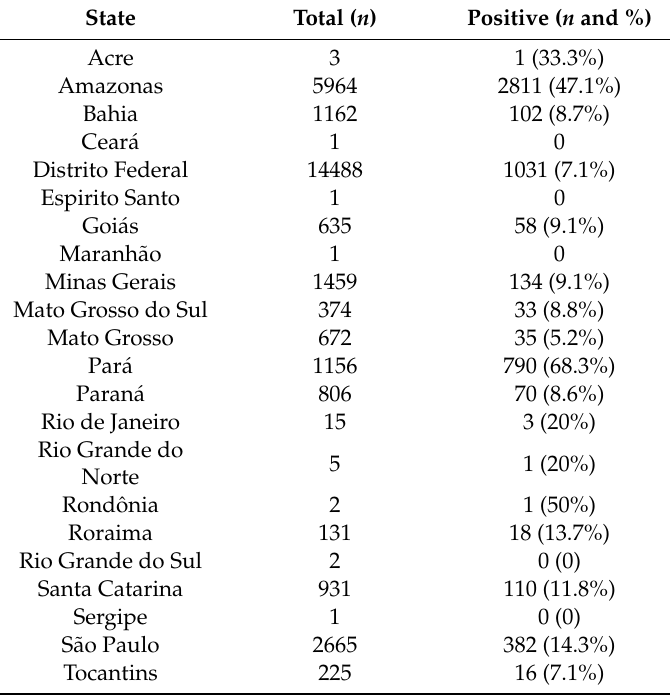
Table 4. Case distribution by